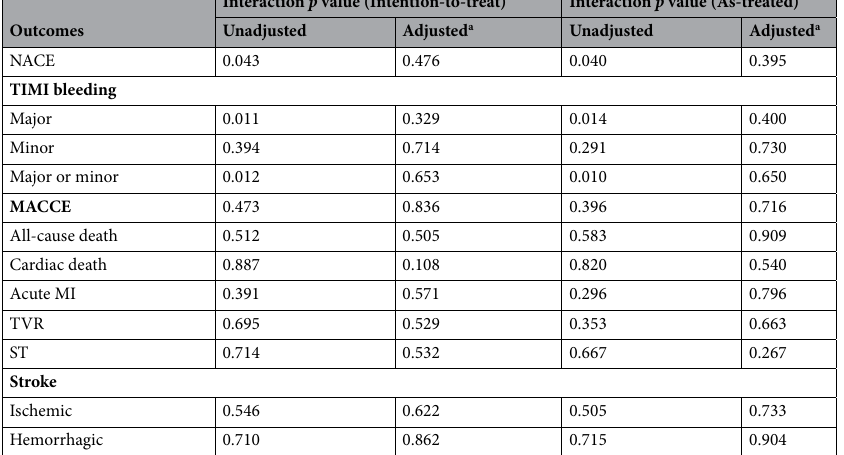
Table 4. Interaction between pre-PCI TIMI during an index PCI (pre-PCI TIMI 0/1 vs. 2/3) and the duration of DAPT (3-mo DAPT vs. 12-mo DAPT) for clinical outcomes. a Adjusted for variables that showed differences with p < 0.05 (age, male, LVEF, hypertension, diabetes mellitus, prior MI, prior PCI, serum creatinine, eGFR, STEMI, beta-blocker, CCB, and stent diameter) (Supplementary material 15) between the pre-PCI TIMI 0/1 and pre-PCI 2/3 groups. Pre-PCI pre-percutaneous coronary intervention, TIMI Thrombolysis In Myocardial Infarction, DAPT dual antiplatelet therapy, 3-mo 3-month, 12-mo 12-month, NACE net adverse clinical events, MACCE major adverse cardiac and cerebrovascular events, MI myocardial infarction, TVR target vessel revascularization, ST stent thrombosis, LVEF left ventricular ejection fraction, eGFR estimated glomerular filtration rate, STEMI ST-segment elevation myocardial infarction, CCB calcium channel